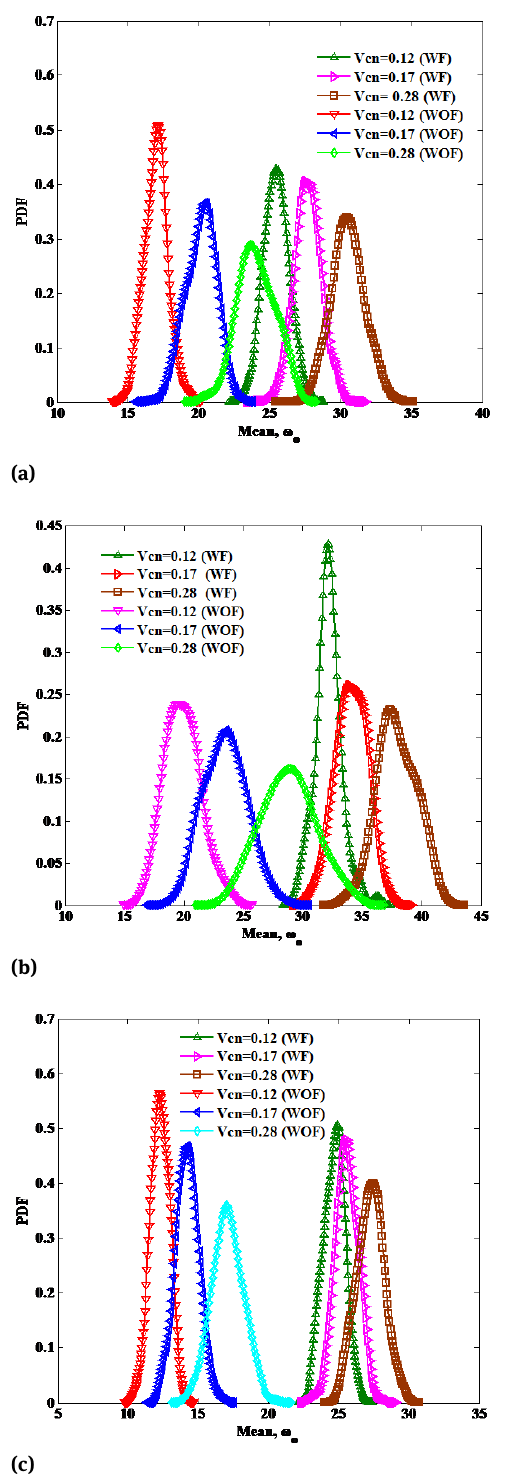
Figure 8: The effect of volume fraction on the PDF of nonlinear fun- damental frequency and combined random variables { b i , ( i = 1 to 16) = (0.10) } on COV with and without foundation for (a) UD and (b) FG-X and (c) FG- Λ distributed CNTRC beams at a / h = 25, W max/ h = 1, V * cn = 0.28 , COC = 0.10, N = 10 4 .